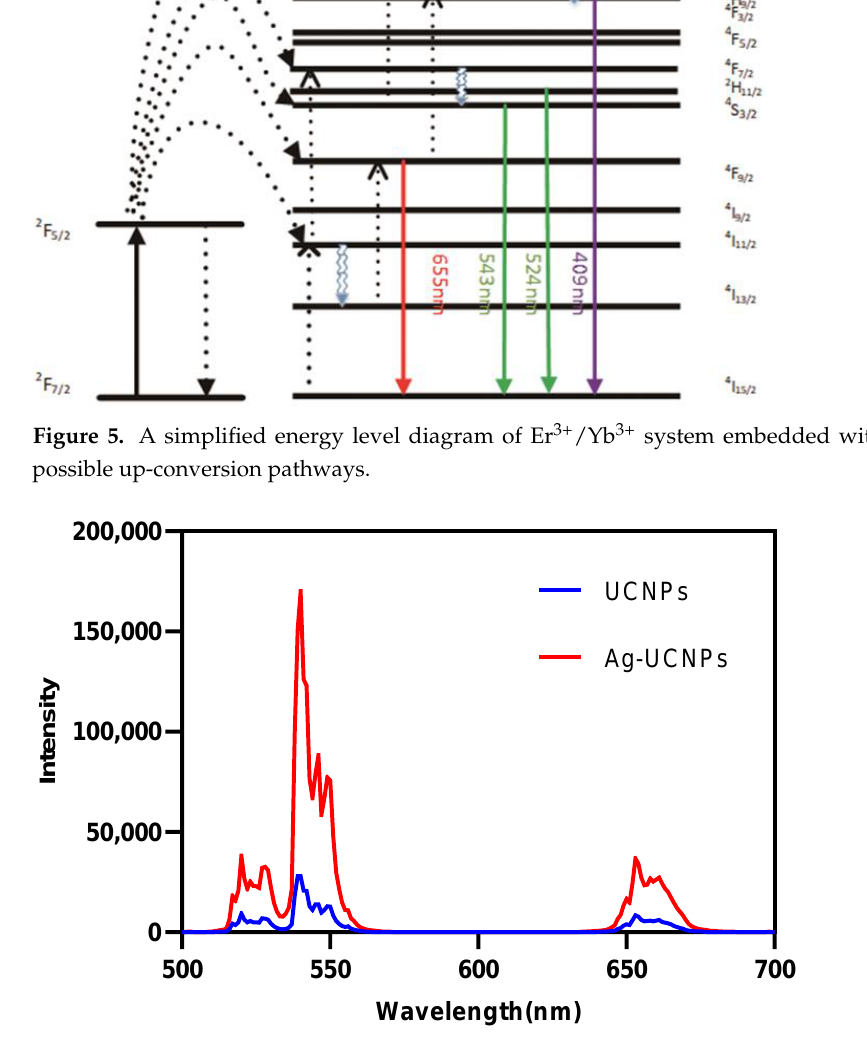
Figure 6. Luminescent intensity of UCNPs and Ag-UCNPs.